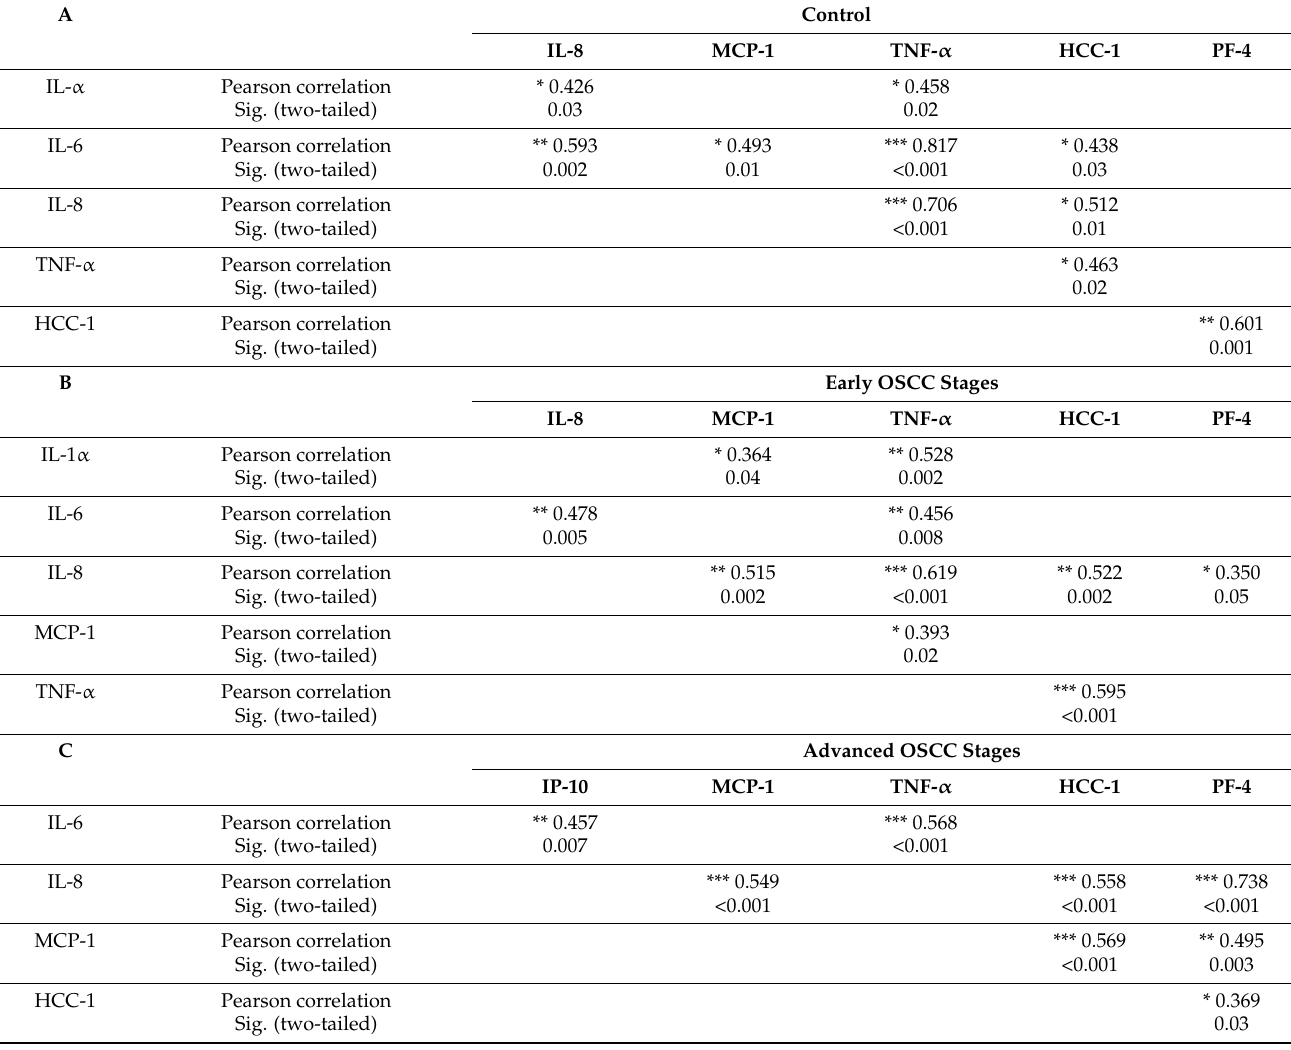
Table 4. Pearson’s pairwise correlation among salivary cytokines in ( A ) control, ( B ) early OSCC and ( C ) advanced OSCC groups. Correlation is significant when p ≤ 0.05 (*), p ≤ 0.01 (**) and p ≤ 0.001